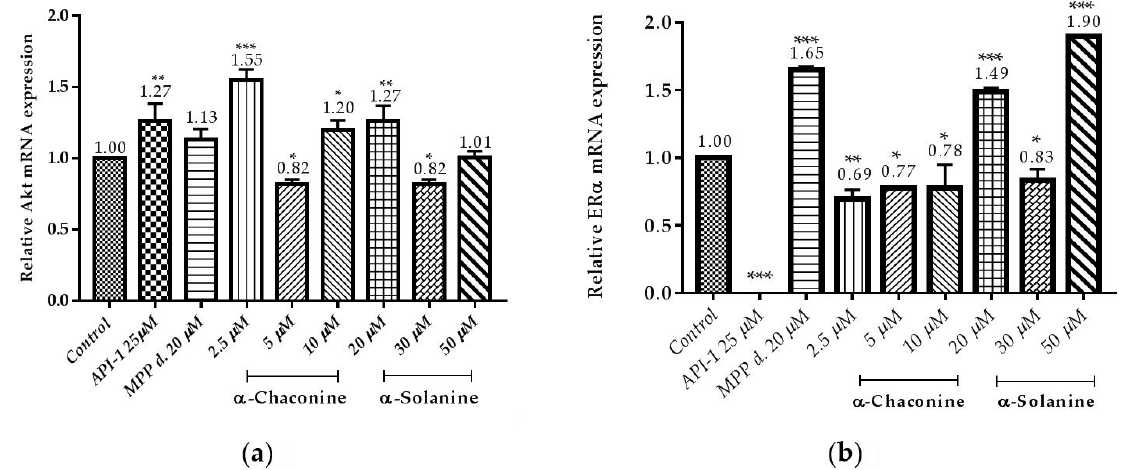
Figure 13. Effects of α -chaconine and α -solanine on suppressing the genes expression of: ( a ) Akt; ( b ) ER α in the RL95-2 cell line. The mRNA expressions were calculated from three repeated data and presented as mean ± SD. * p < 0.1, ** p < 0.01 *** p < 0.001 compared with the untreated control.